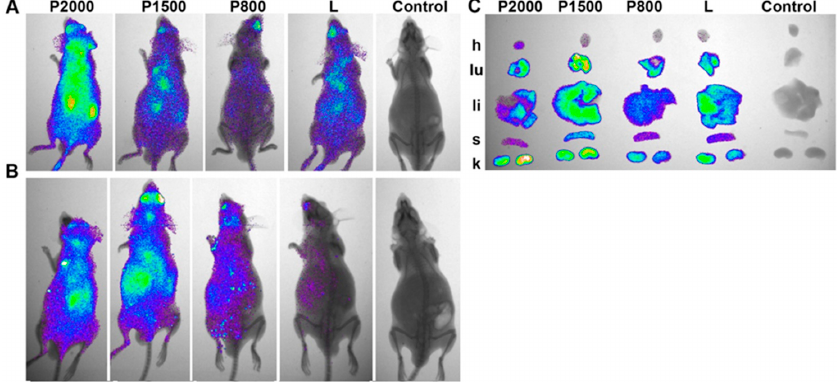
Figure 4. Biodistribution of Cy5.5-labeled siMDR complexed with liposomes P800 , P1500 , P2000 or L in SCID mice. ( A , B ) Lifetime fluorescence imaging of SCID mice (dorsal orientation view) 20 min (exposure time 20 s) ( A ) or 24 h (exposure time 60 s) ( B ) after i.v. injection. ( C ) Images of dissected organs of SCID mice at 24 h time point (h: heart, lu: lungs, li: liver, s: spleen, k: kidney). L /siRNA and P /siRNA lipoplexes were formed at N/P = 4/1; control: non-injected